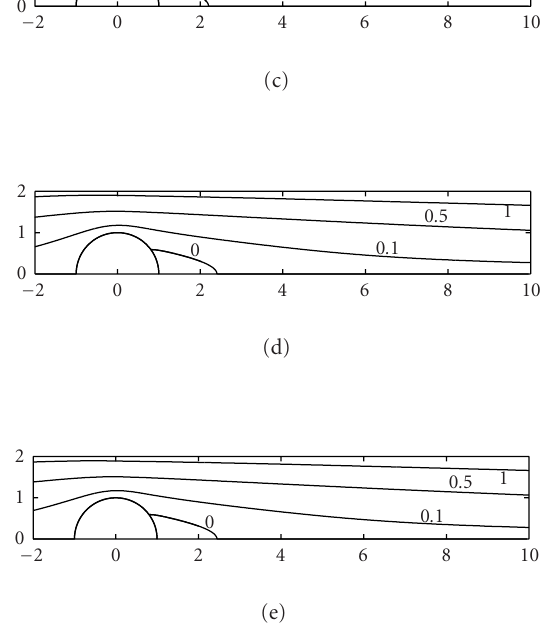
Figure 4.3 . Streamlines for Re = 40. (a) N = 0, (b) N = 2, (c) N = 5, (d) N = 10, and (e) N =